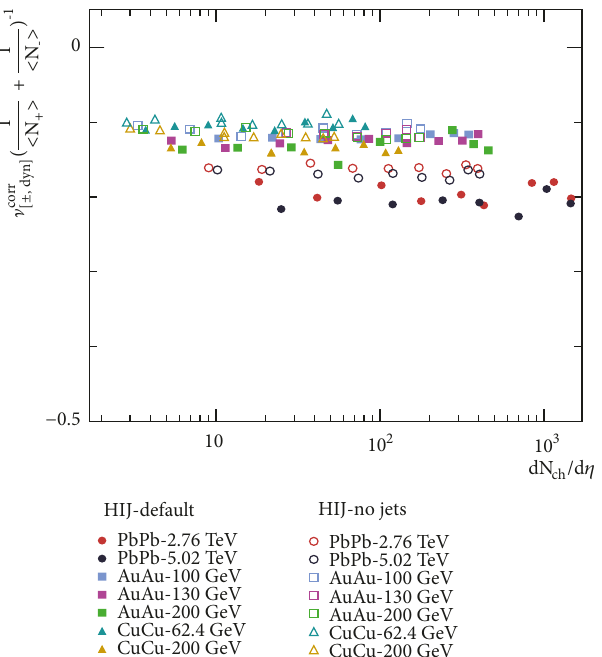
Figure 11: 1/(1/⟨𝑁 + ⟩ + 1/⟨𝑁 − ⟩) scaling of corrected net charge fluctuations for two types of HIJING events at different